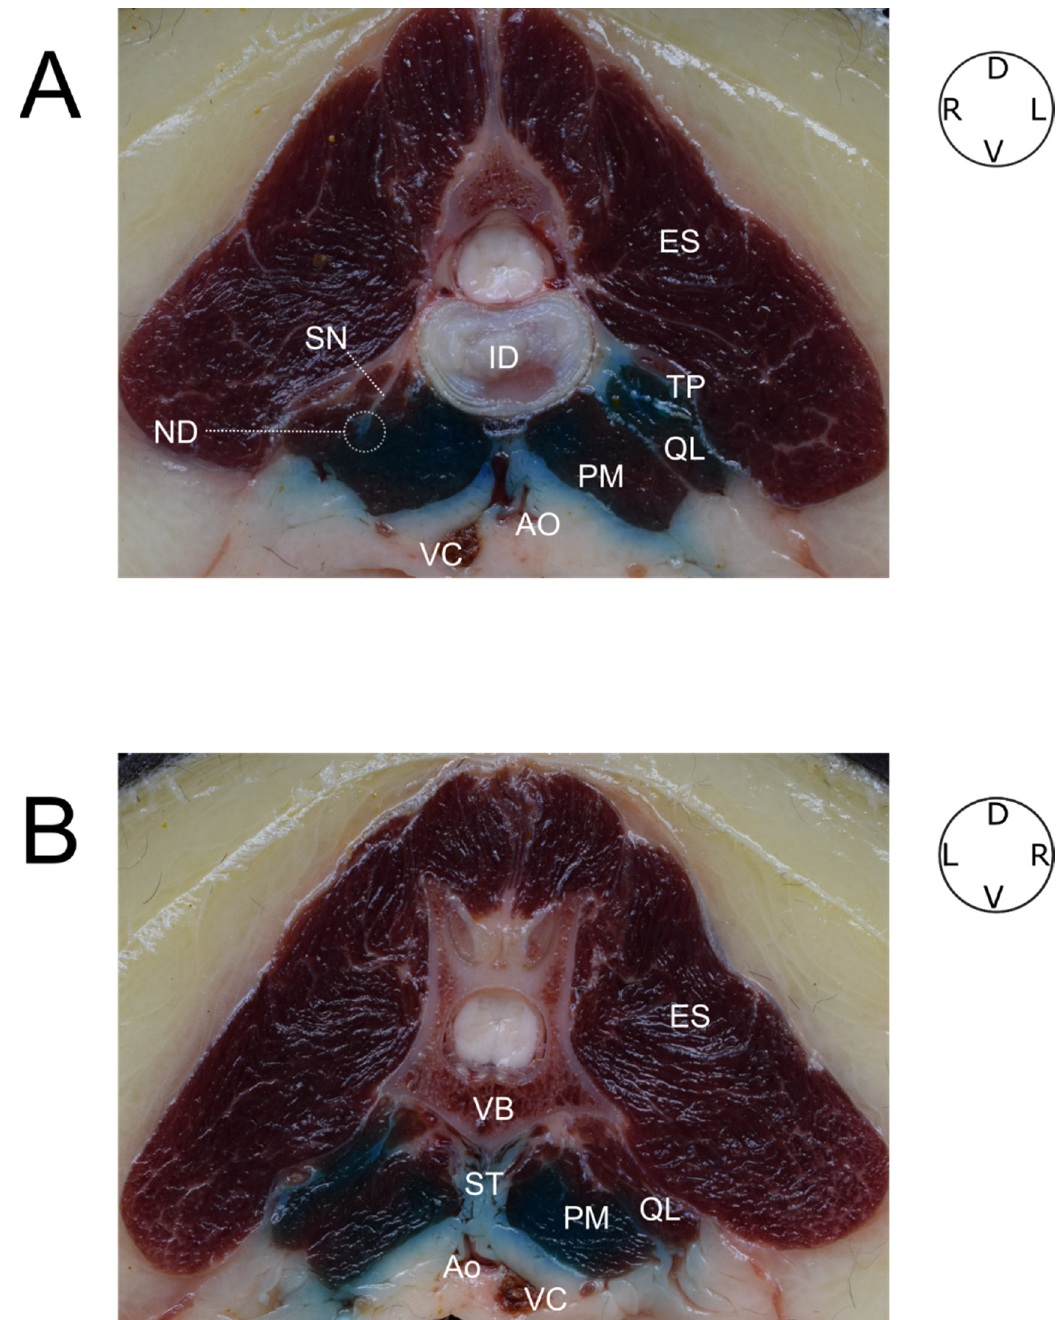
Figure 9. ( A ) Cranial view of a cross-section of the intervertebral disk and the caudal segment of L2. On the right side a spinal nerve can be observed leaving the intervertebral foramen and passing through the quadratus lumborum muscle. On the opposite side the presence of dye between the quadratus lumborum, the psoas minor muscles and the vertebral body can be observed. An intense coloration of the sympathetic trunk area between both psoas minor muscles is observed. ( B ) Dye distribution through the muscles and the sympathetic trunk area in a cranial vision of the center of L2. At this point, the spinal nerves cannot be seen. ES, erector spinae muscles; TP, transverse process; QL, quadratus lumborum muscle; PM, psoas minor muscle; ID, invetervebral disk; Ao, aorta; VC, vena cava; SN, spinal nerve; ND, nerve dyed; VB, vertebral body; ST, sympathetic trunk; D, dorsal; V, ventral; L, left side; R, right side.